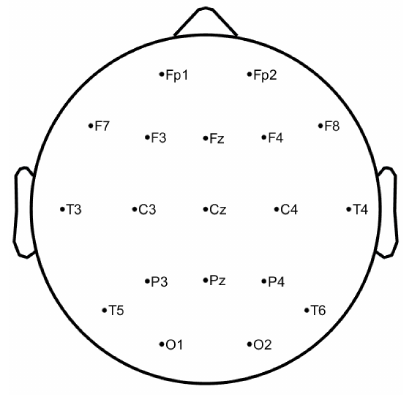
Figure 1. 10–20 EEG system—electrodes positions at scalp